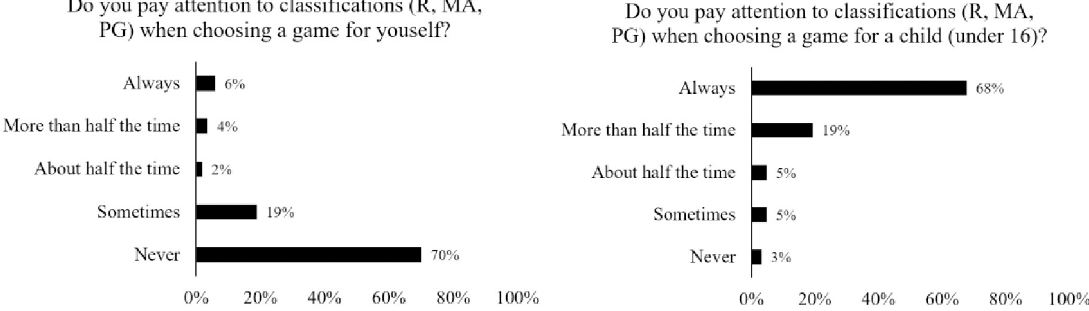
Fig 5. Response distributions regarding attention to classifications when choosing for the self and for children.